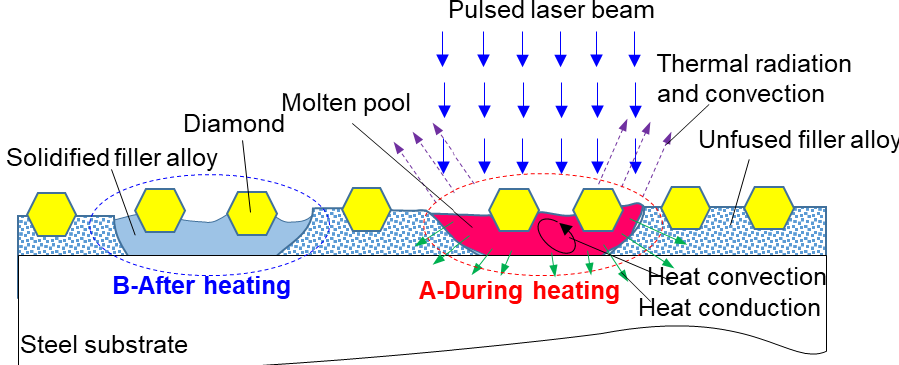
Figure 2. Diamond brazing by spot heating with pulsed laser.